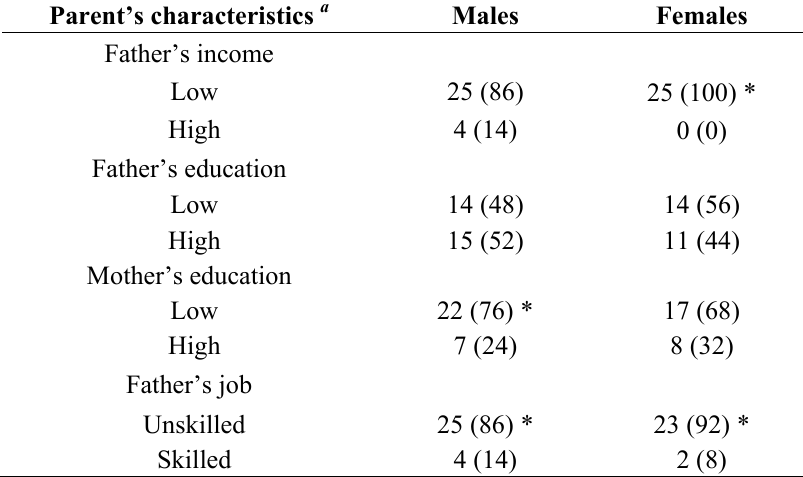
Table 1. Differences in well water use by socioeconomic characteristics in the study children.